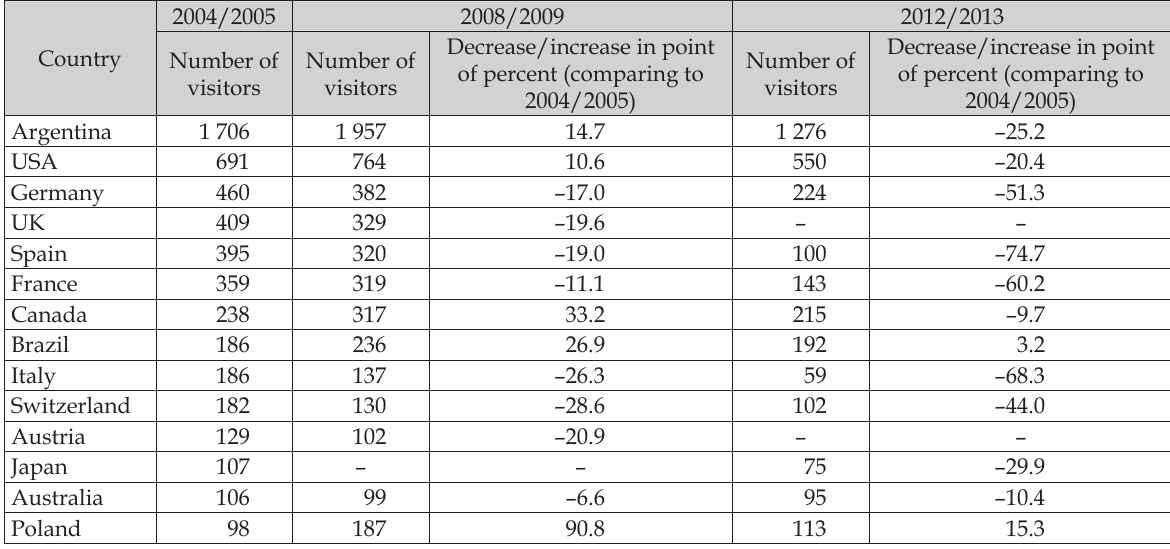
Table 2. Visitors in the Aconcagua massif according to countries in years 2004/2005, 2008/2009 and 2012/2013. Country